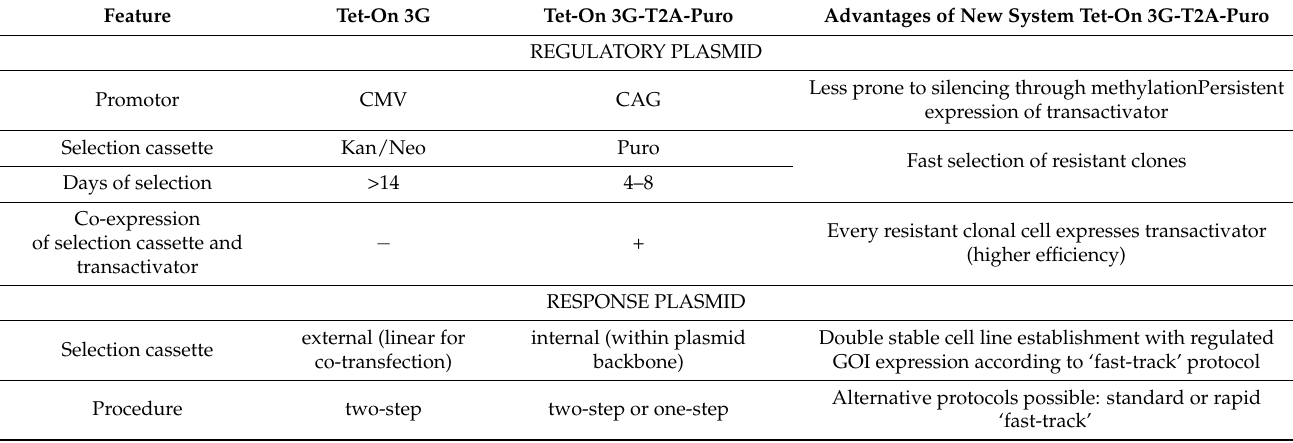
Table 1. Comparison of Tet-On 3G and Tet-On 3G-T2A-Puro inducible expression